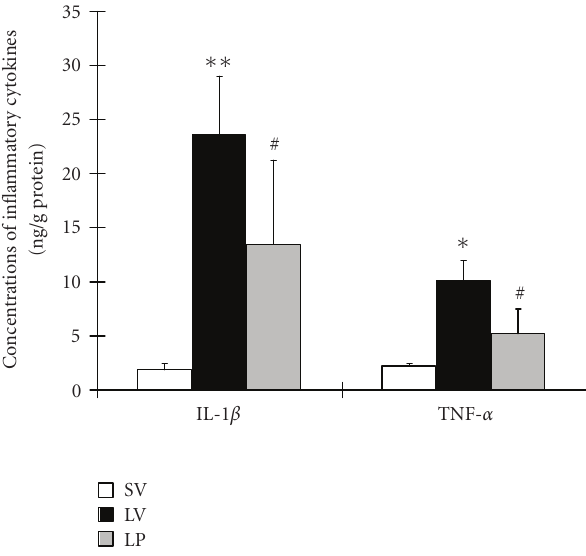
Figure 5: Changes of inflammatory mediators in the small in- testines as determined by ELISA in SV group (sham + vehicle, n = 6), LV group (lesion + vehicle, n = 6), and LP group (lesion + progesterone, n = 6). TBI could induce the significantly increased concentrations of IL-1 β and TNF- α in rat ileum tissue. In LP group, the intestinal concentrations of IL-1 β and TNF- α were markedly down-regulated as compared with that of LV group. ∗∗ P < . 01 and ∗ P < . 05 versus SV group; # P < . 05 versus LV